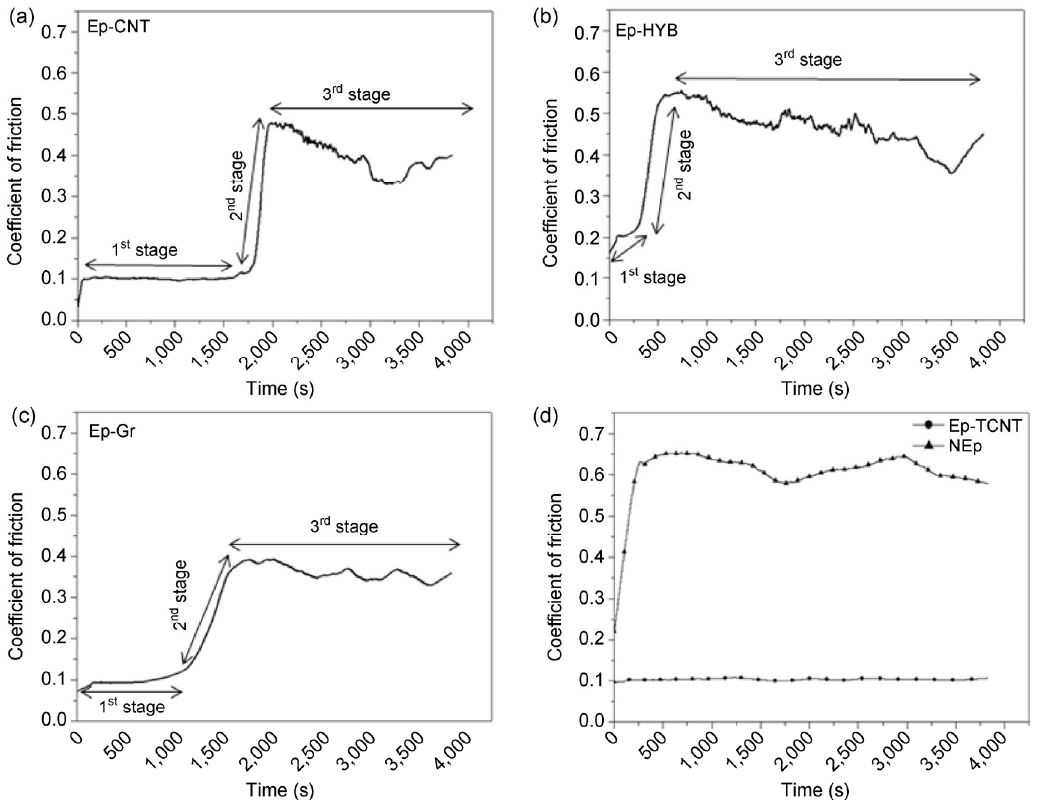
Fig. 3 Coefficient of friction evolution for the different types of samples at 400 rpm and F n = 4